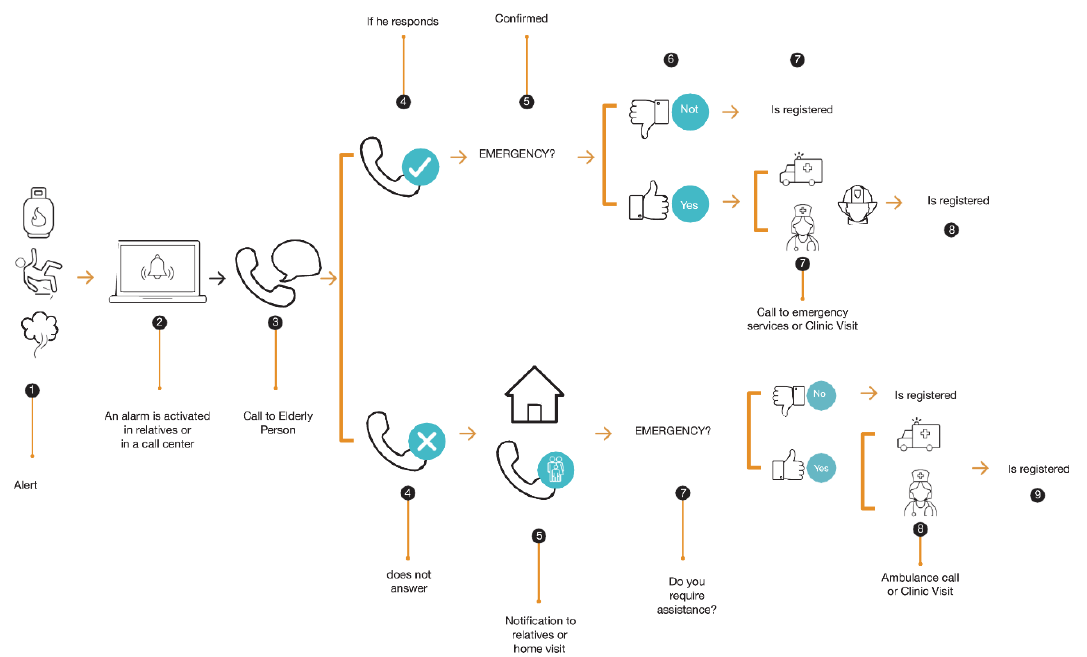
Figure 2. Quida alert system action protocol.